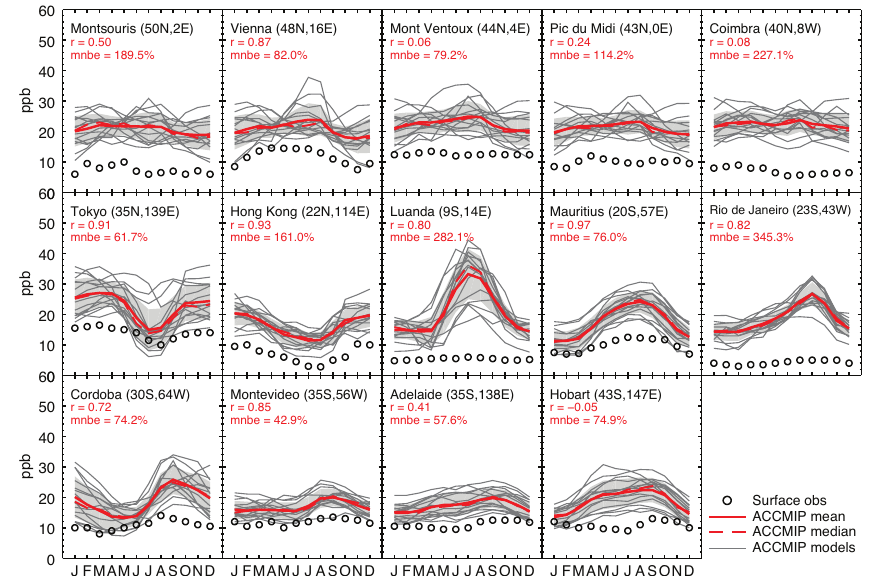
Fig. 2. Comparison of 1850s modelled seasonal cycles of ozone (lines) with observations of ozone (circles) at 14 surface sites. The observa- tions have large, but unquantified uncertainties, so no error bars are included. The correlation ( r ) and the mean normalised bias error (mnbe) of the mean model to the observations are also shown for each